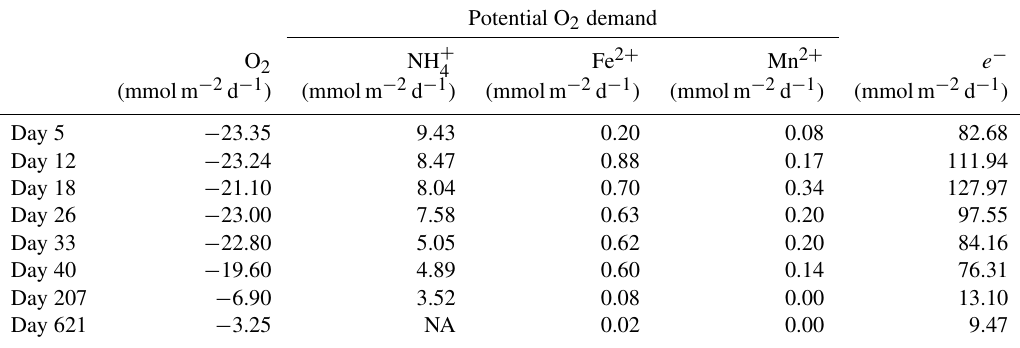
Table 2. Mass balance of O 2 consumption. The diffusive uptake of O 2 , as calculated from the O 2 depth profiles (column 2), was compared to the potential O 2 demand from the oxidation of NH + , Fe 2 + and Mn 2 + (columns 3–5). The O 2 consumption of the oxidation of NH + 4 and Mn 2 + was determined based on the stoichiometry of NH + , Fe 2 + and Mn 2 + oxidation with O 2 , as described in Reed et al. (2011). The 4 oxidation of dissolved Fe 2 + and Mn 2 + only played a minor role in the total O 2 consumption during the experiment, contributing only 0.9% to 3.8% and 0.1% to 0.4%, respectively.